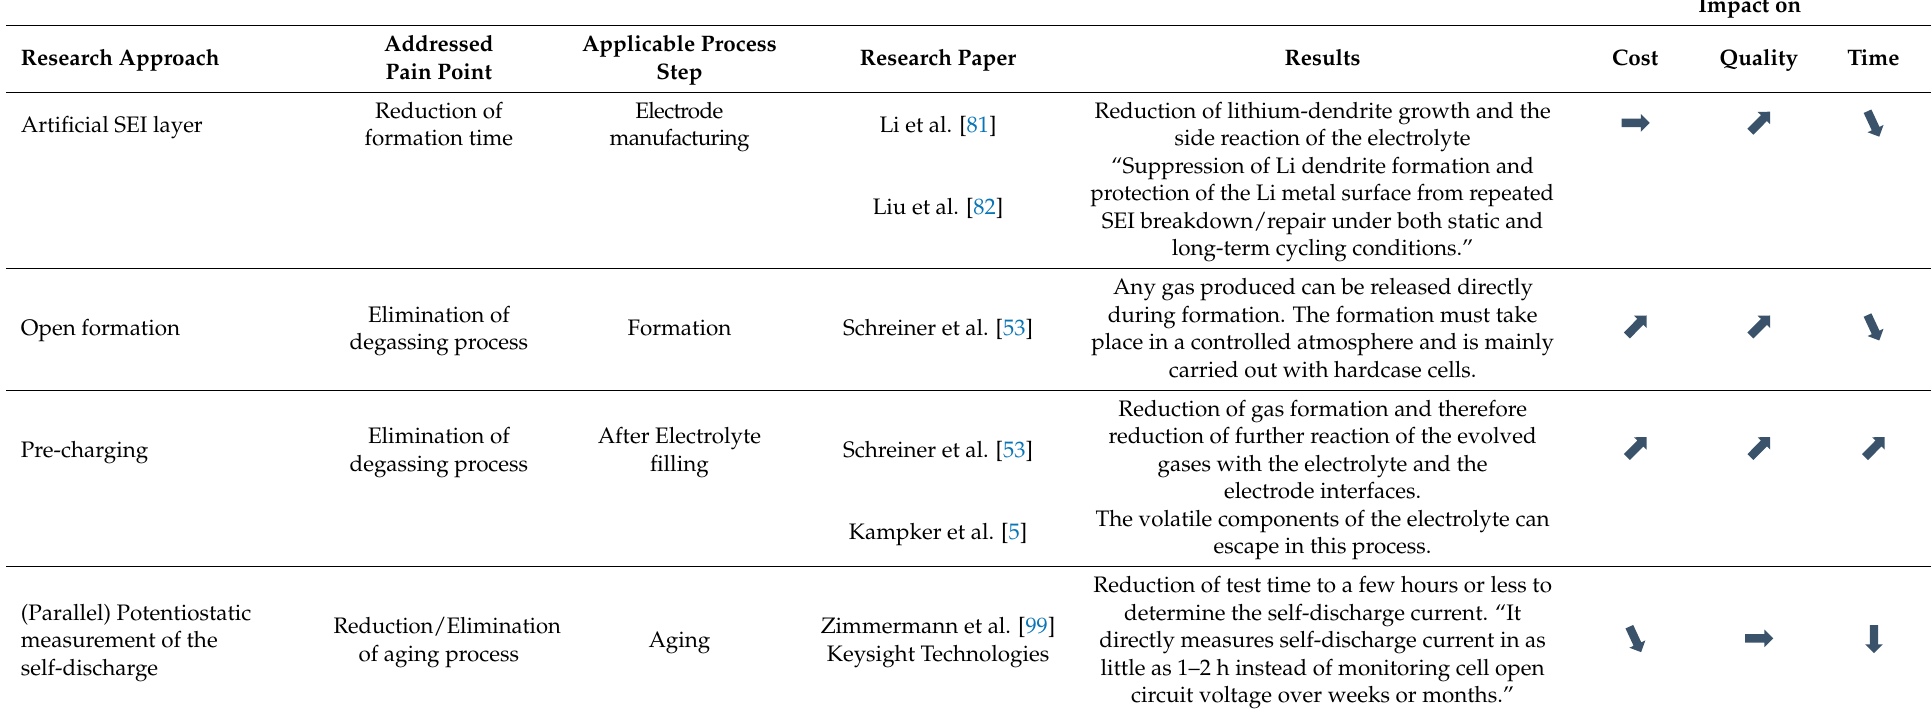
Table 1. Research solution